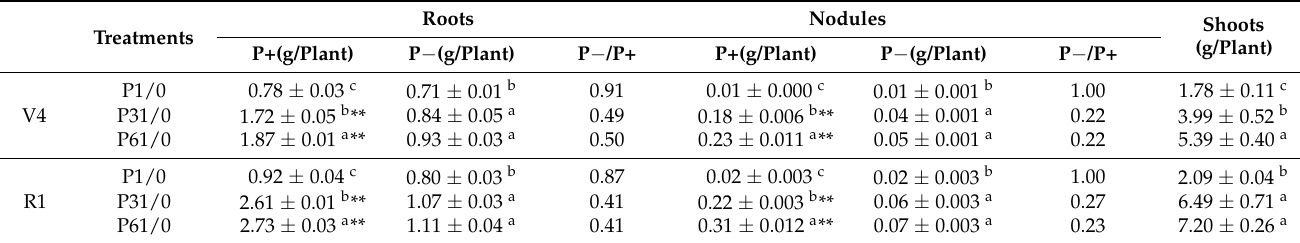
Table 2. Effect of P supply on the dry weight of dual-root soybeans.